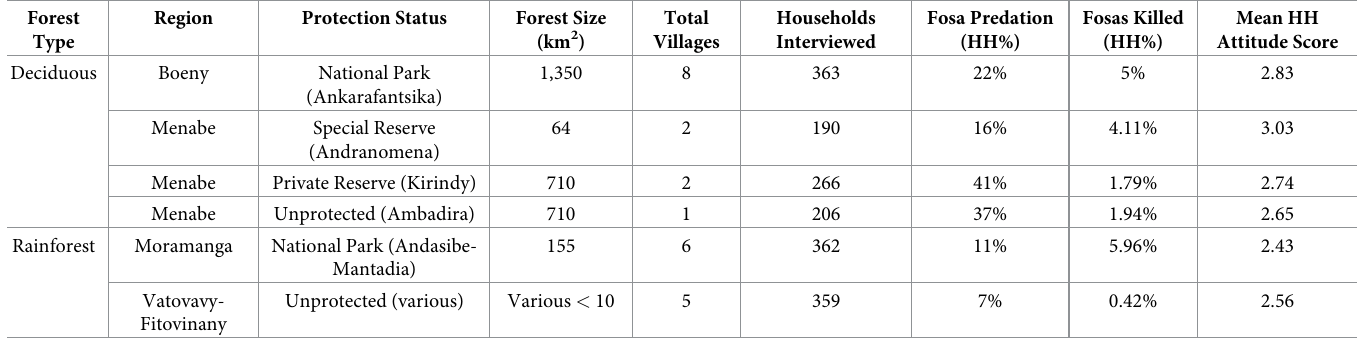
Table 1. Summary of our study regions, and the results of our three models. Including: percentage of households (HH) that experienced fosa poultry predation; per- centage of households that killed a fosa; and the average household attitude score. Forest Type